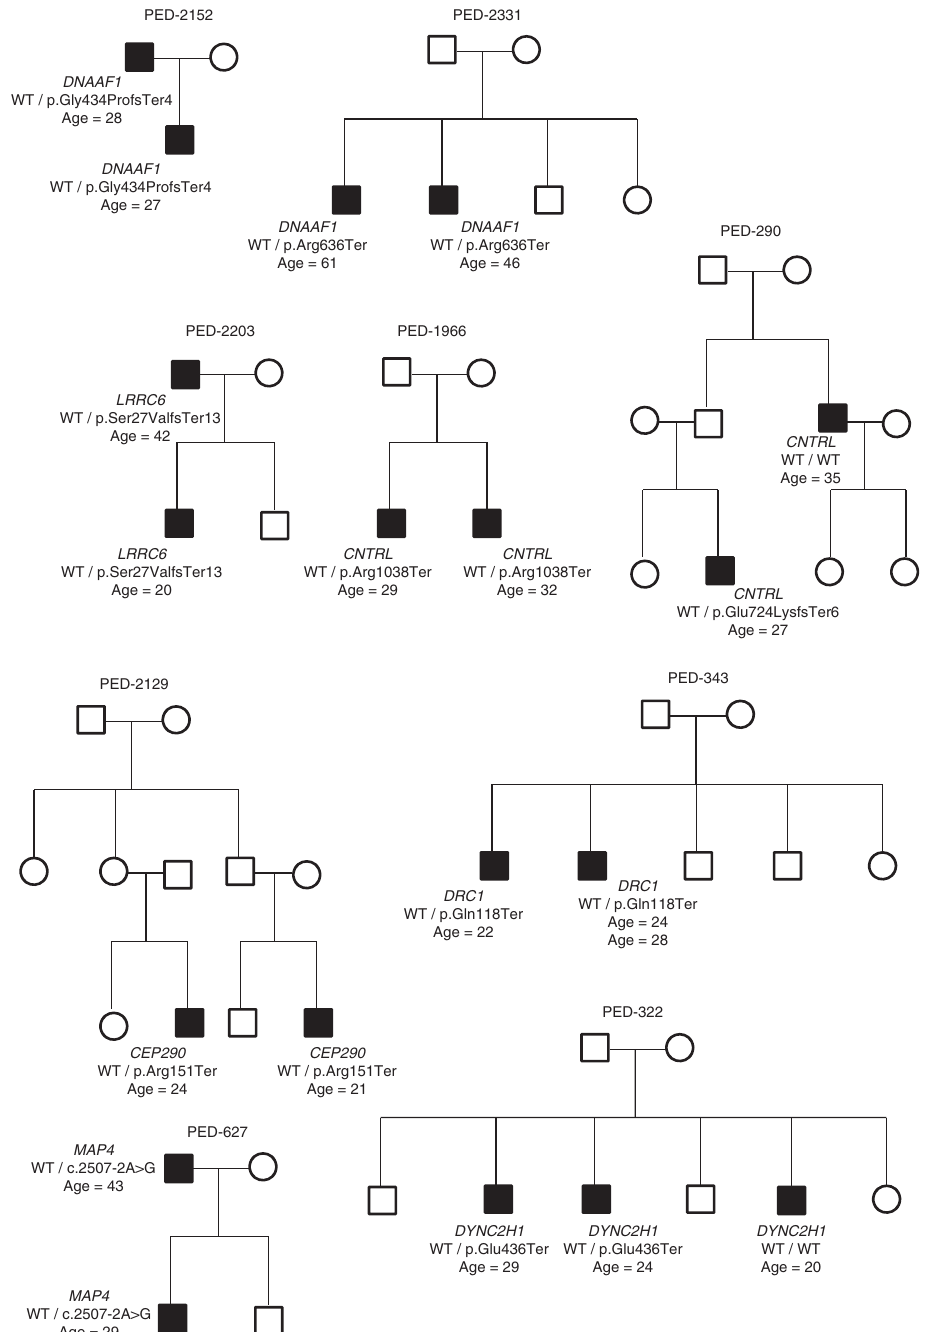
Figure 3 | Segregating TGCT pedigrees of cilia-microtubule pathway gene carriers. Circles, female; and squares, male. TGCT cases denoted by shaded symbols; ages refer to age at diagnosis of